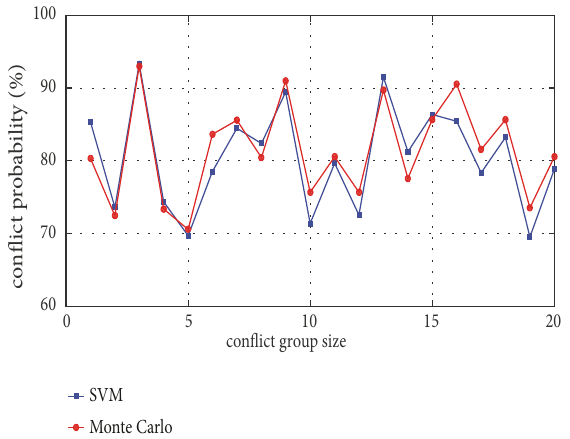
Figure 4: Classifier performance comparison before and after SMOTE treatment.